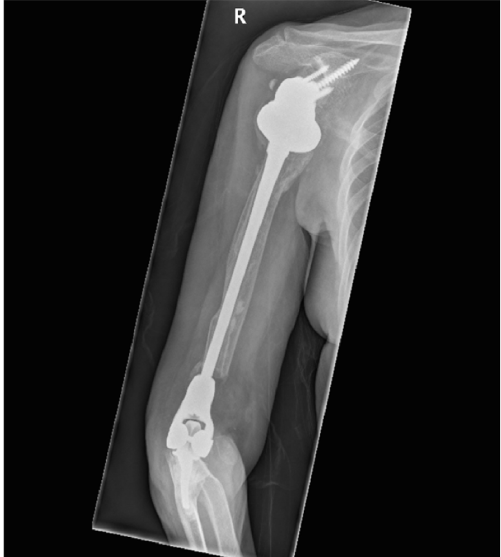
Figure 6. The radiograph shows IMHR for the third case, and it illustrates preservation of most of the humeral shaft, which is bypassed by an intramedullary rod, while using a reverse shoulder replacement component proximally and a smaller distal humeral prosthetic body over an elbow replacement ulnar component.